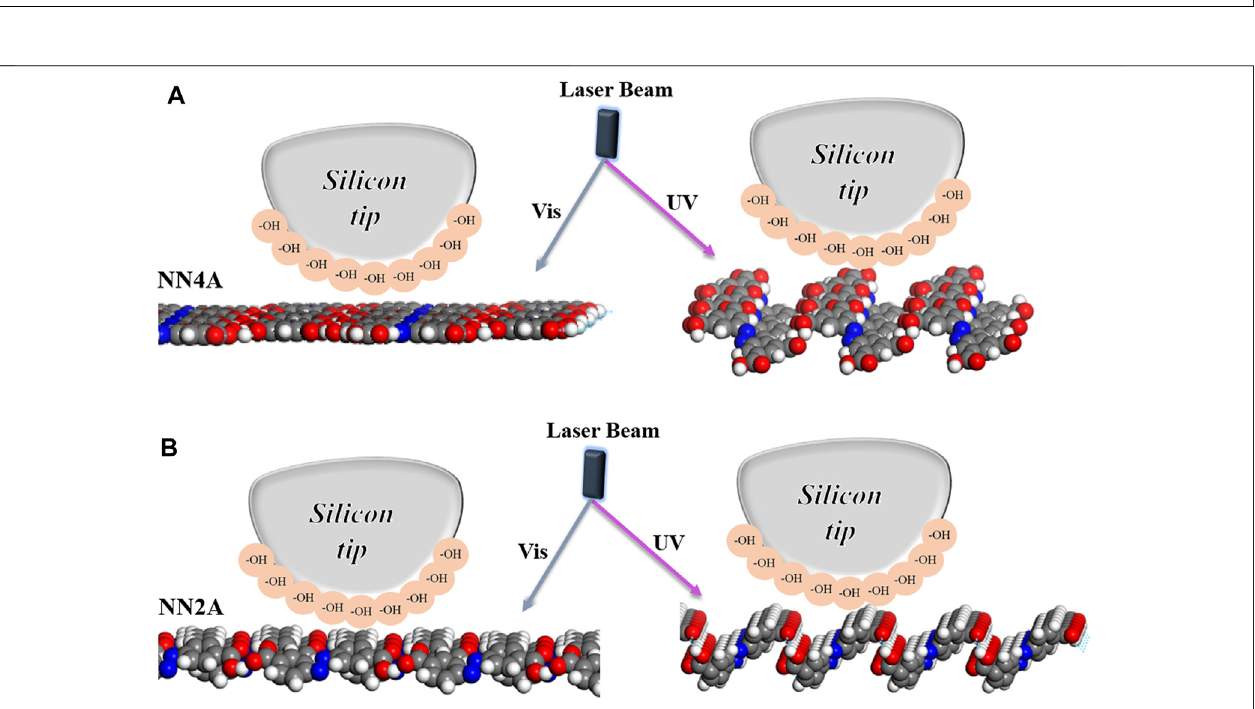
FIGURE 4 | 3D schematic diagram of two molecular layers con fi guration arrangement under AFM probe scanning. The irradiation time of UV lamp with 360 nm is 40 min and the power is 8 W/m.